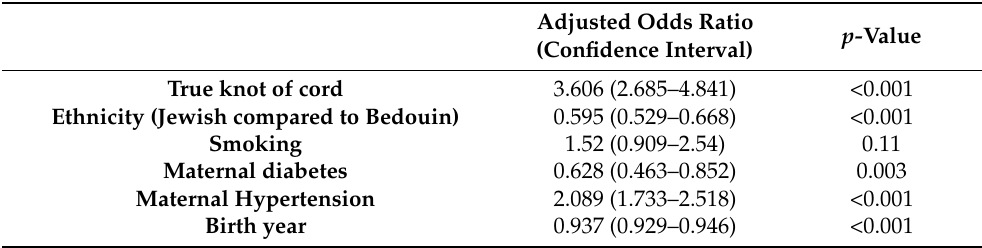
Table 2. Multivariable regression analysis for the association between true knot of cord and perinatal mortality.